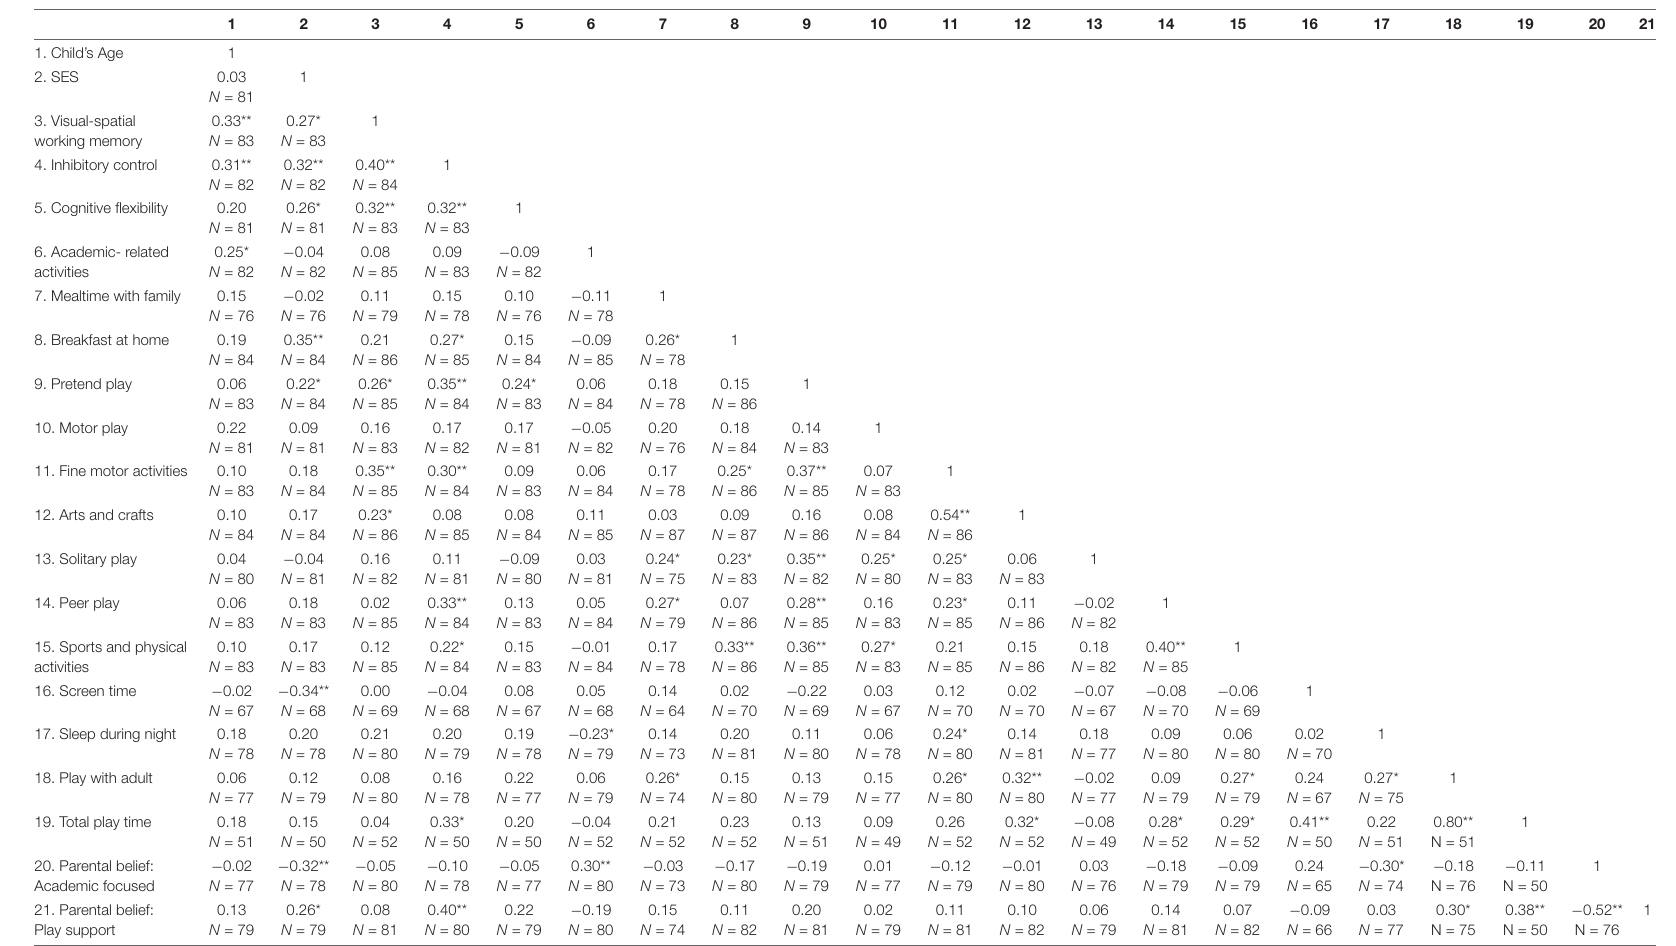
TABLE 4 | Bivariate correlations among demographics, home activities, parental play beliefs, and executive